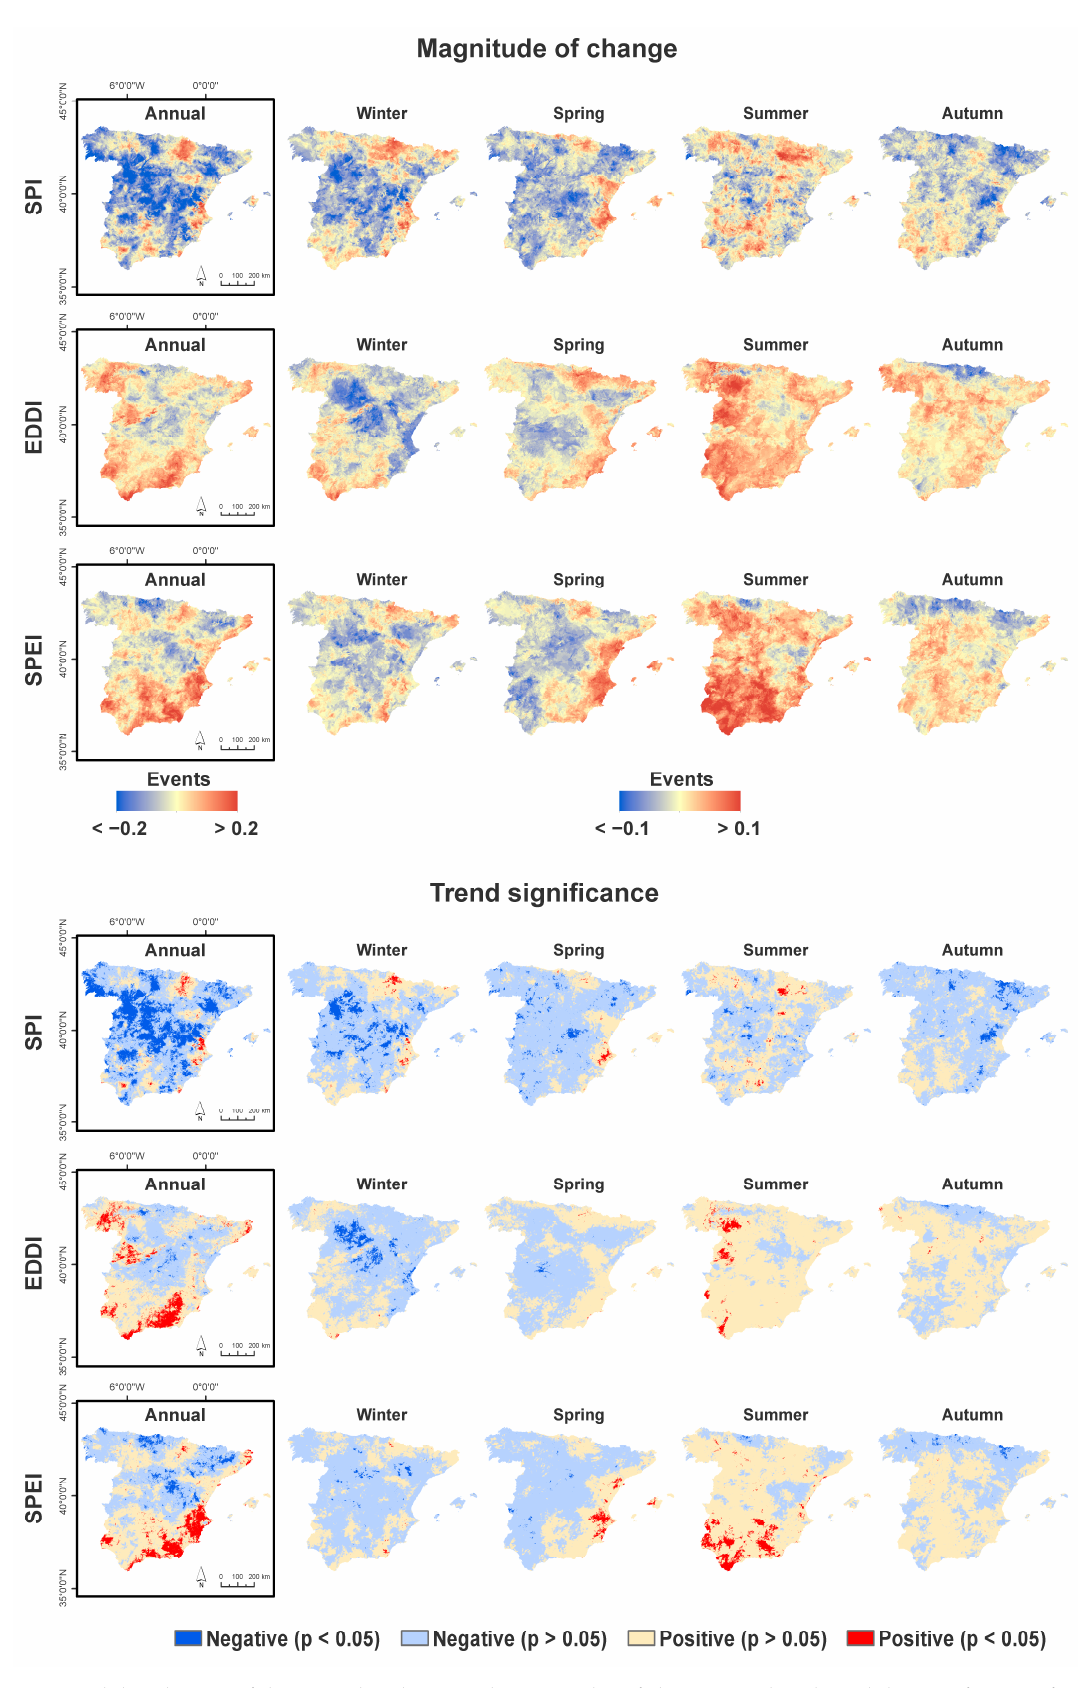
Figure 5. Spatial distribution of the annual and seasonal magnitudes of change per decade and the significance of trends of flash drought events identified by the SPI, EDDI, and SPEI over the period